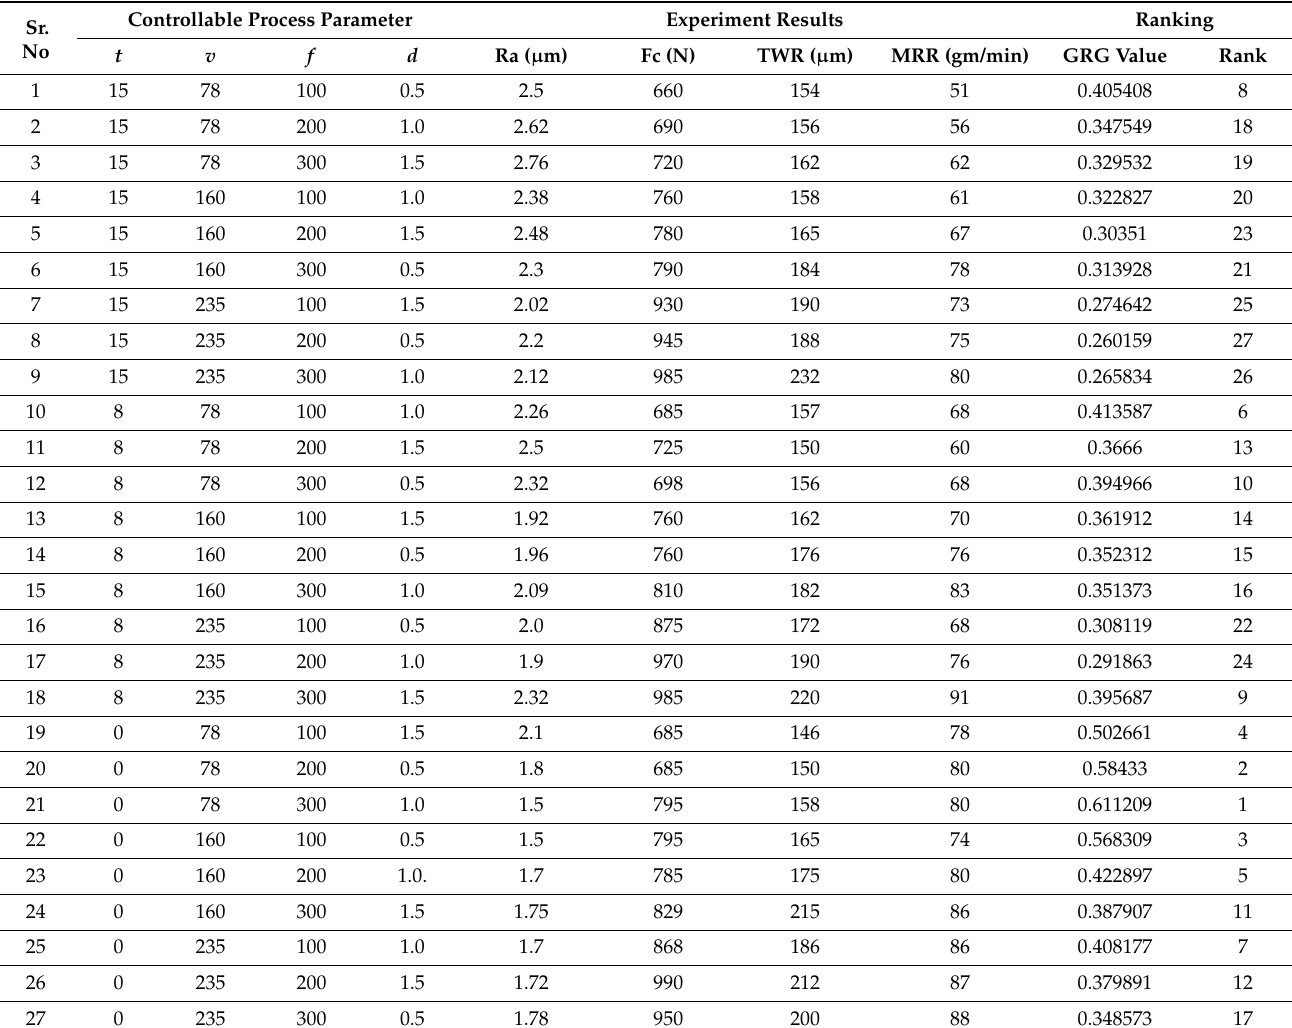
Table 8. Ranking by GRG